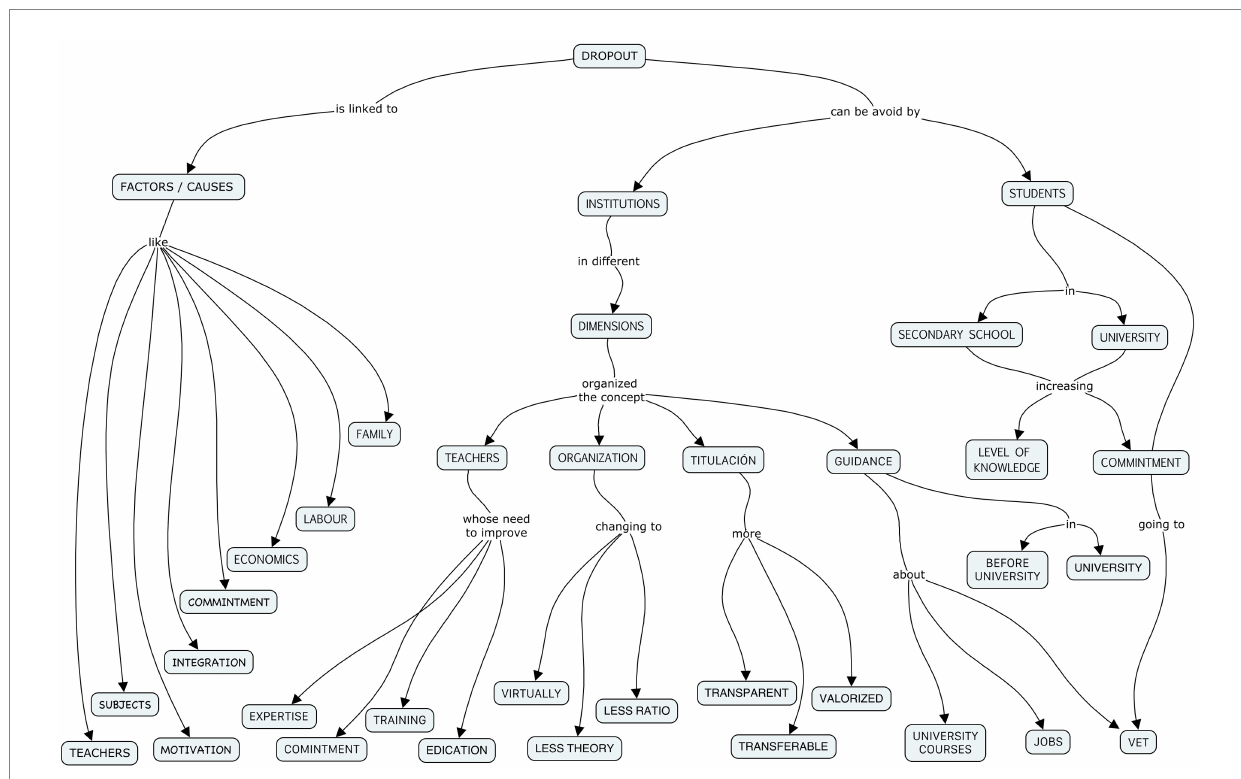
FIGURE 9 Knowledge model representing the factors associated with dropout and with advice from students who dropped